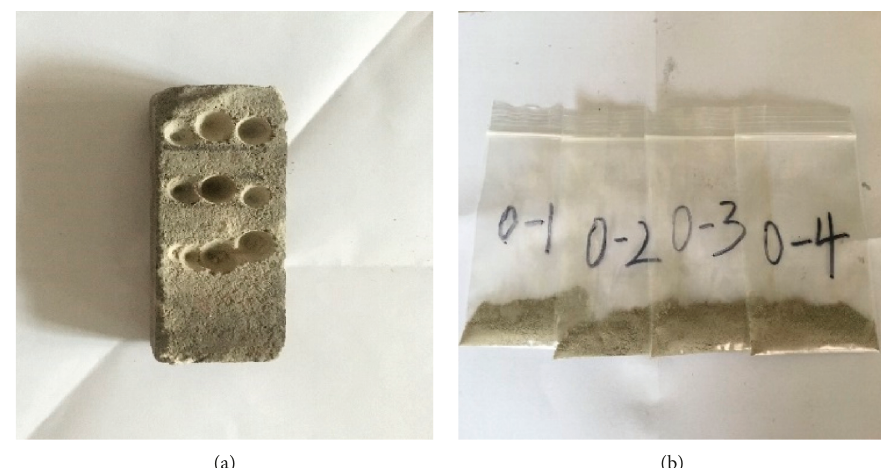
Figure 2: Test powders used in DSC: (a) drilling in the specimen and (b) test powder mixed by drilling samplings at the beginning of the